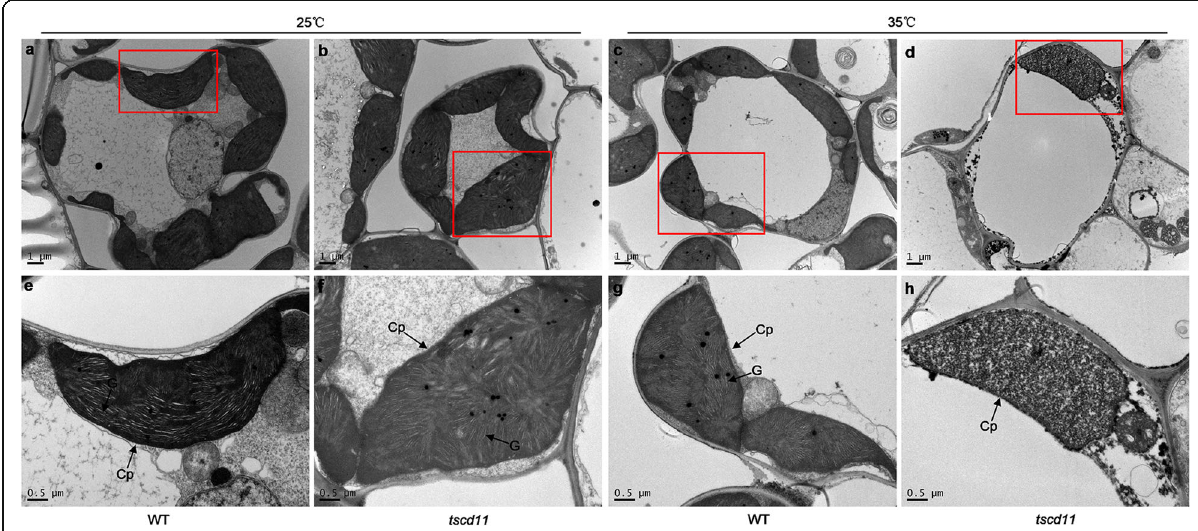
Fig. 2 Transmission electron micrographs of chloroplasts in WT and the tscd11 mutant. a, b Chloroplasts structure from WT and tscd11 at 25 °C. c , d Chloroplasts structure from WT and tscd11 at 35 °C. e-h are enlargements of a-d , respectively. CP, chloroplast; G, grana lamella